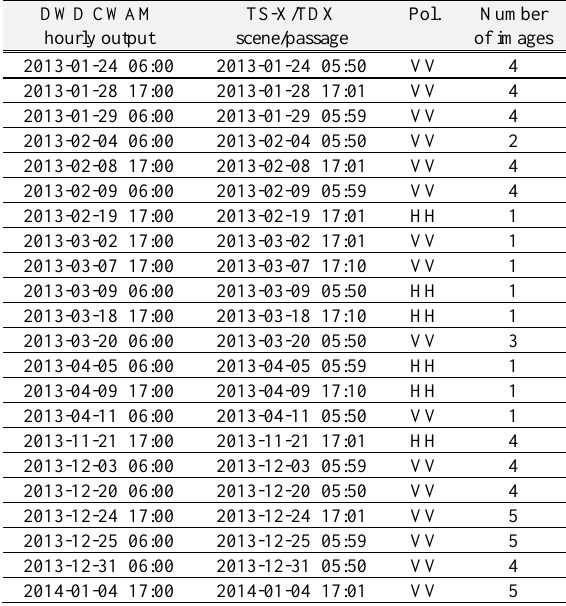
Table 1. Colocation CWAM wave model and TS-X/TD-X StripMap acquisitions: 21 overflights with 64 TS-X images DWD CWAM hourly